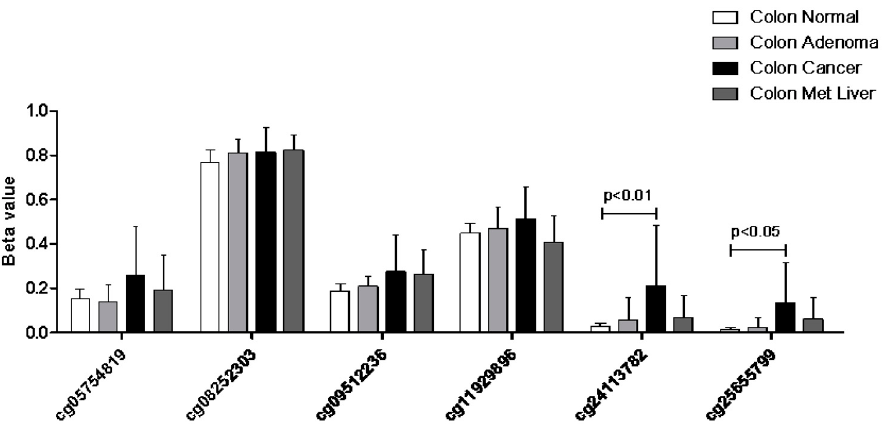
Figure 6. Methylation profiles of colorectal cancer samples as determined in the GSE53051 microarray dataset. (a) Methylation pattern of the KCNMA1 gene; (b) Principal Component Analysis (PCA) of normal colon samples ( n = 18, green samples), colon adenoma ( n = 10, blue samples), colorectal adenocarcinoma ( n = 9, red samples), and colorectal liver metastases ( n = 6, violet samples). PCA graph was constructed using the first and second components (top panel) and the first and third components (bottom panel) for the KCNMA1-associated beta values.